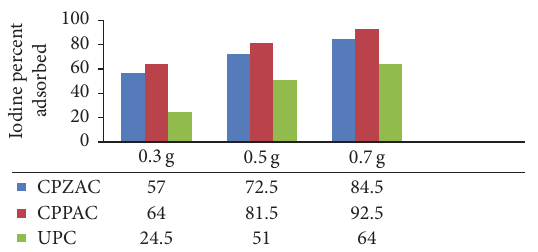
Figure 2: Iodine adsorption chart.